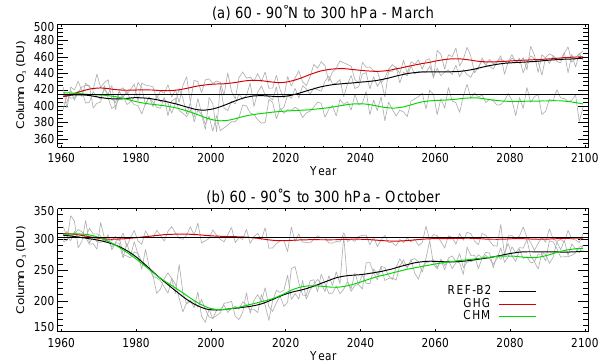
Fig. 11. Time series of ensemble average column ozone for March from 60–90 ◦ N (a) and October over 60–90 ◦ S (b) . The grey lines show the ensemble average monthly average for each year and the colour lines show the data after smoothing with a Gaussian filter with a width of eight years.